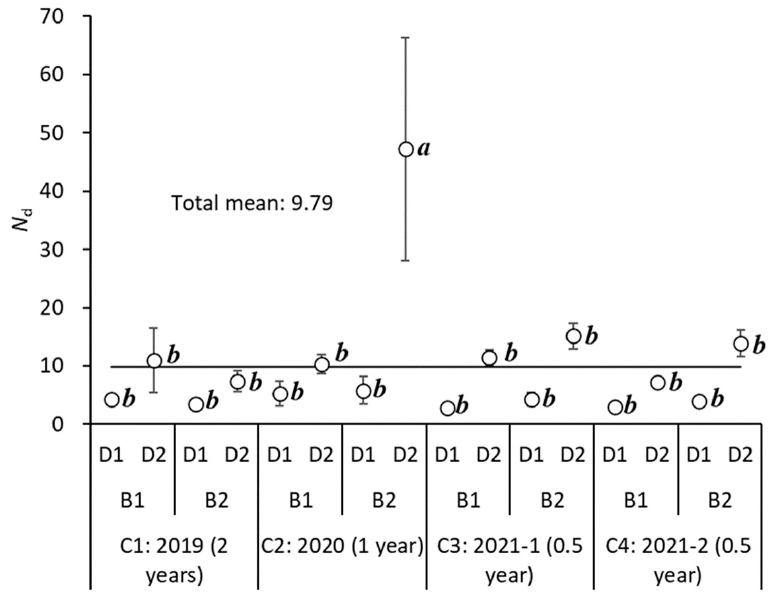
Figure 13. Interaction of Factor B (downhill side or uphill side), Factor C (fiscal year of construction), and Factor D (penetrating depth) of Site 2 on the N d -value. The error bars and different letters have the same meaning as in Figure 9. p < 0.01, n = 6. B1: Downhill side, B2: Uphill side; D1: 0–50 cm, D2: 50–100